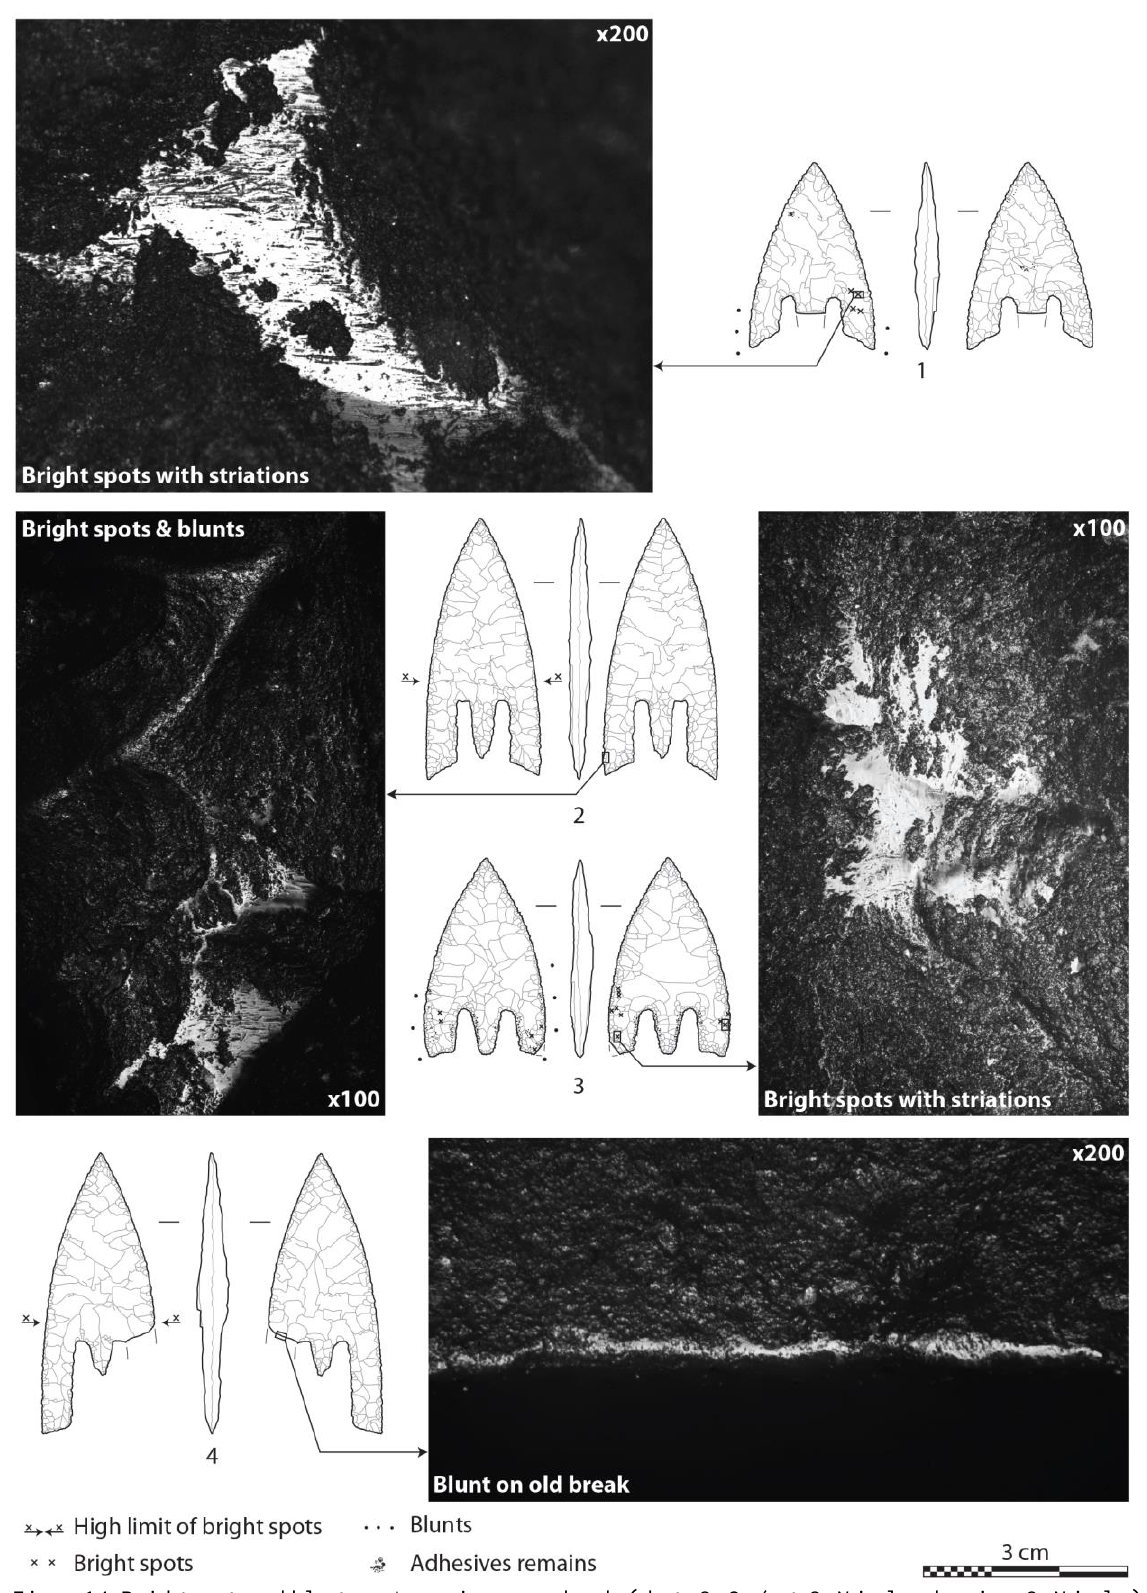
Figure 14. Bright spots and blunts on Armorican arrowheads (photo C. Guéret, C. Nicolas; drawings C. Nicolas). 1. arrowhead from Brun-Bras barrow, Saint-Adrien, Côtes-d'Armor; 2 and 4. arrowhead from Prat-ar-Simon- Pella grave, Lannilis, Finistère; 3. arrowhead from Crec’h-Perros-Guirec,